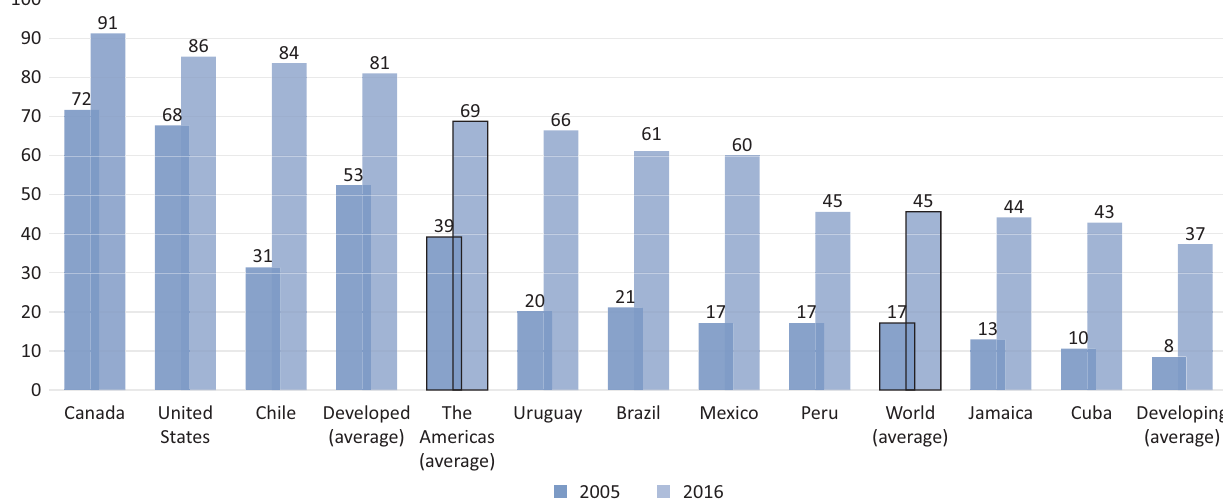
Figure 1. Individuals using the internet (percentages), 2005–2016. Assembled by author Matias Dodel with data from International Telecommunications Union (ITU,